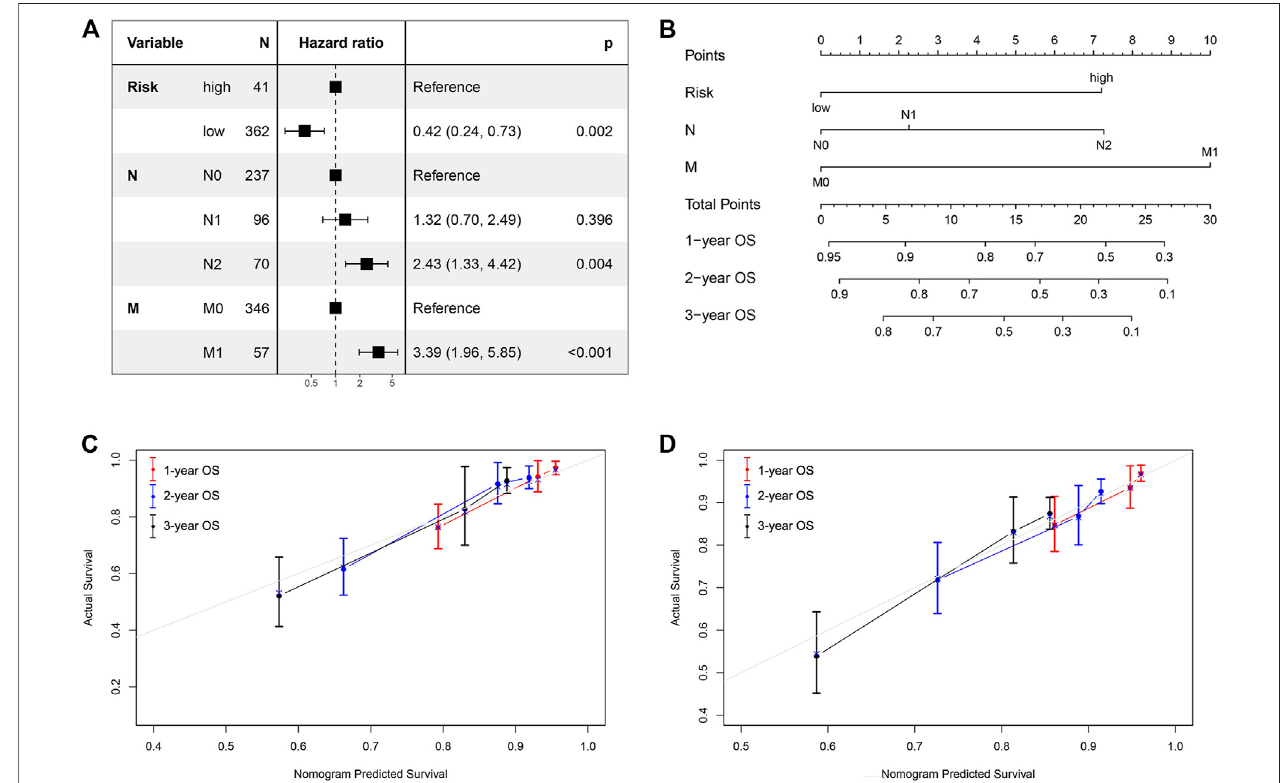
FIGURE 5 | Nomogram and calibration curve for predicting the probability of 1-, 2- and 3-years OS for patients with COAD. (A) The hazard ratios of the risk score and clinical factors based on multivariate COX analysis. (B) Anomogram integrates iron metabolism gene signature and other prognostic factors in patientswith COAD; (C, D) The calibration curve of the nomogram in TCGA cohort and GSE39582 validation dataset.